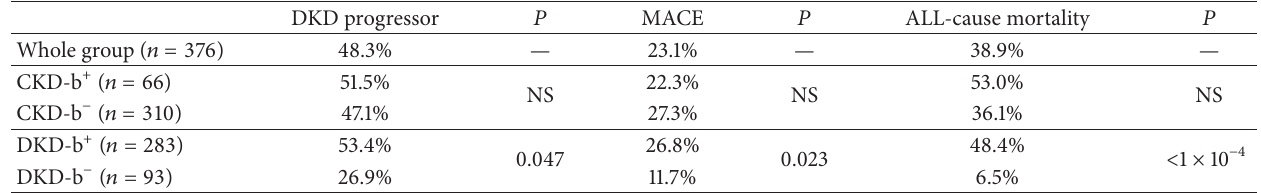
Table 3: Cumulative incidence of DKD progression, MACE and all-cause mortality in the whole group and subgroups. DKD progressor 𝑃 MACE 𝑃 ALL-cause mortality 𝑃 Whole group ( 𝑛 = 376 ) 48.3% — 23.1% — 38.9% — CKD-b + ( 𝑛 = 66